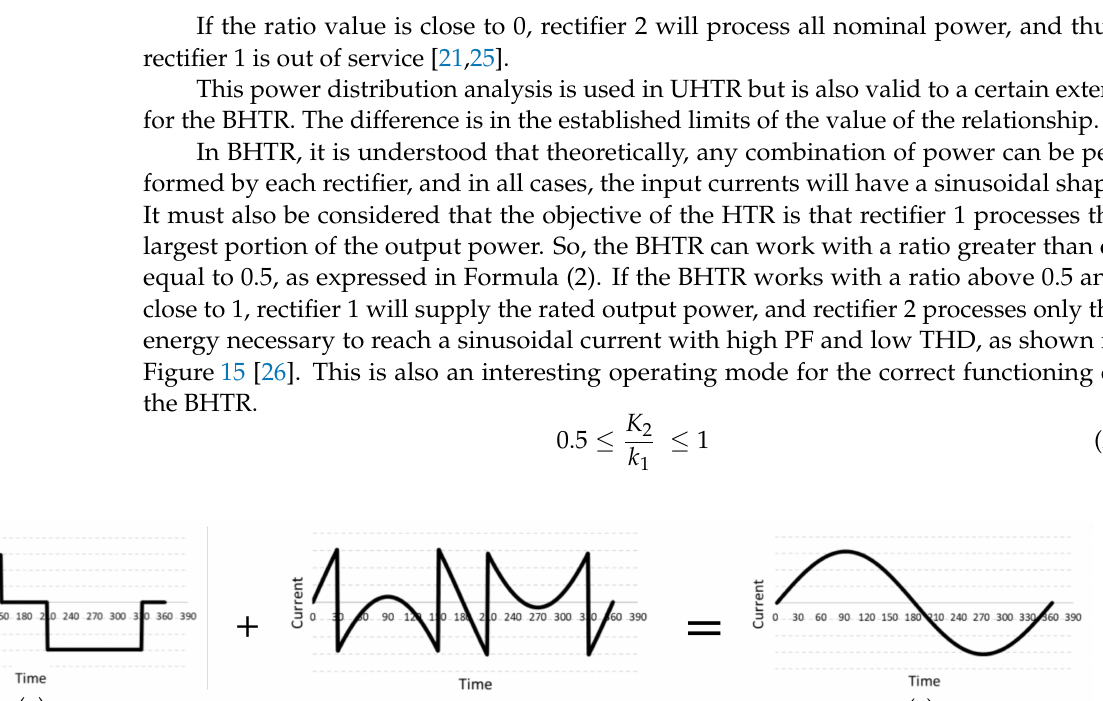
Figure 14. Current waveforms in phase a of the HTR. ( a ) Input current in rectifier 1. ( b ) Input current in rectifier 2. ( c ) Input current (sinusoidal) in the HTR.